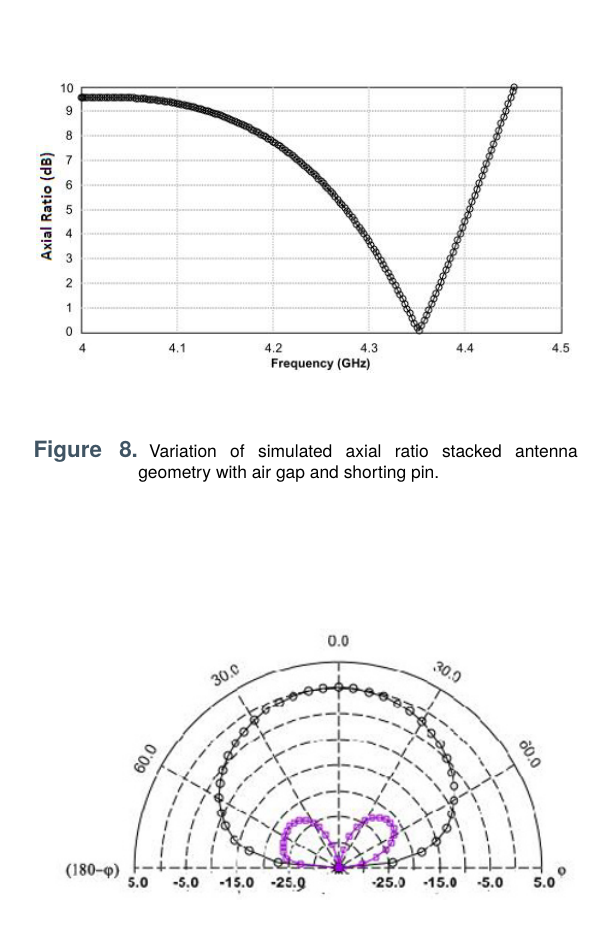
Figure 9. E-plane left and right circular polarization patterns at 4.352